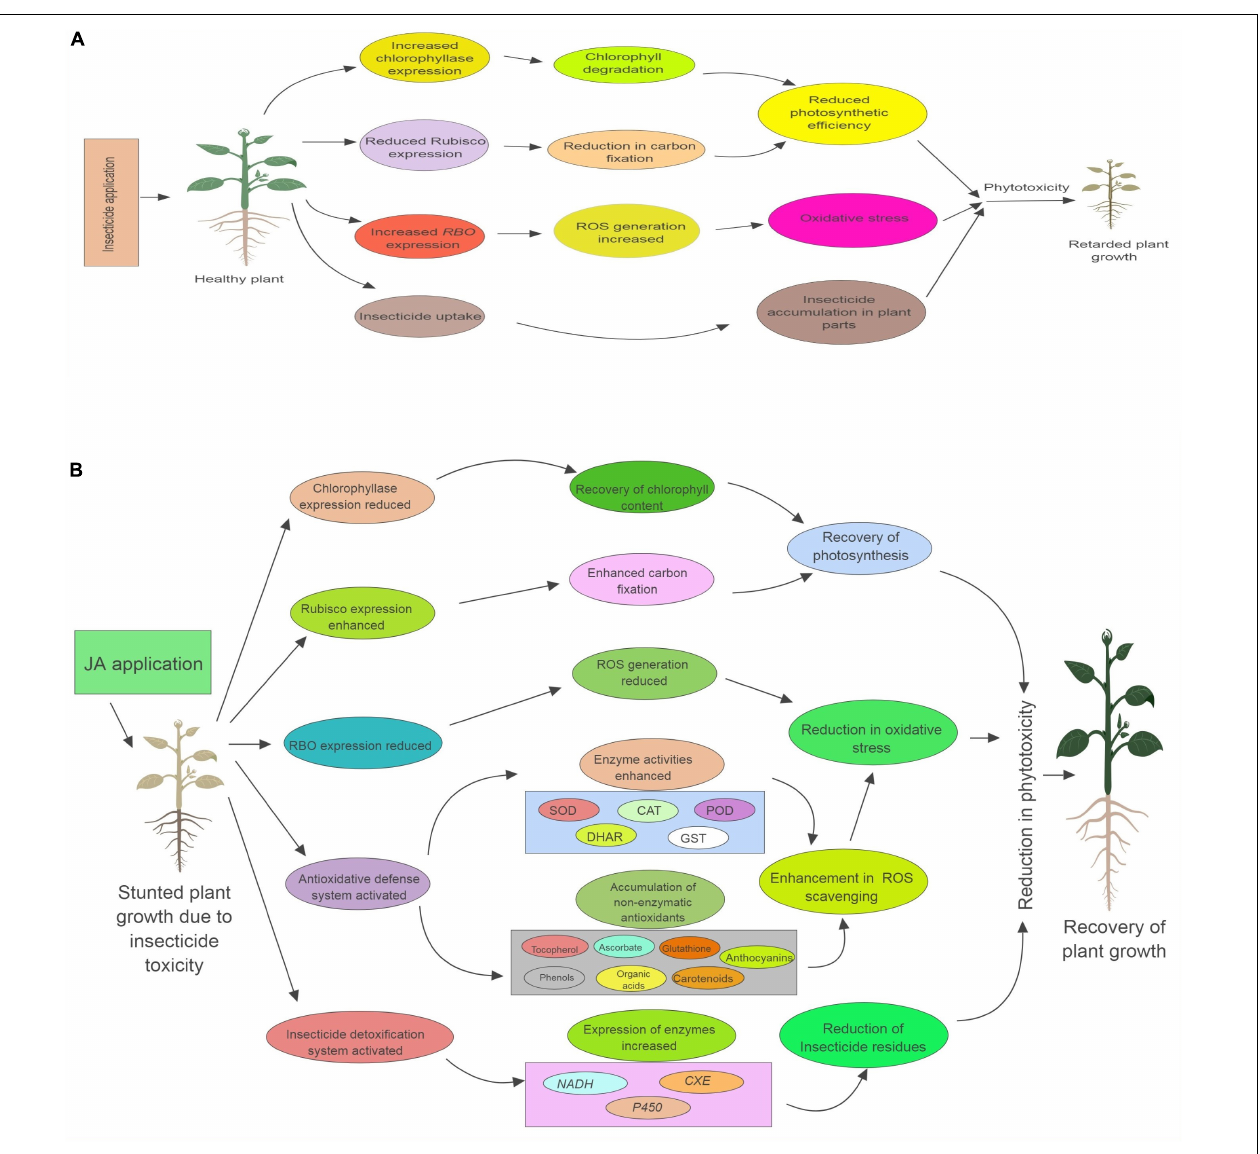
FIGURE 8 | Role of exogenous applied jasmonic acid (JA) in plants under insecticide toxicity. (A) Describes how insecticide causes toxicity to plants. (B) Describes the various physiological process regulated by JA application, which help in reducing the insecticide induced phytotoxicity. RBO , respiratory burst oxidase; Rubisco, Ribulose-1,5-bisphosphate carboxylase/oxygenase; NADH, NADH-ubiquinone oxidoreductase ; CXE, carboxylesterase; P450 , cytochrome P450 monooxygenase; ROS, reactive oxygen species; SOD, superoxide dismutase; CAT, catalase; POD, peroxidase; DHAR, dehydroascorbate reductase; GST, glutathione- S